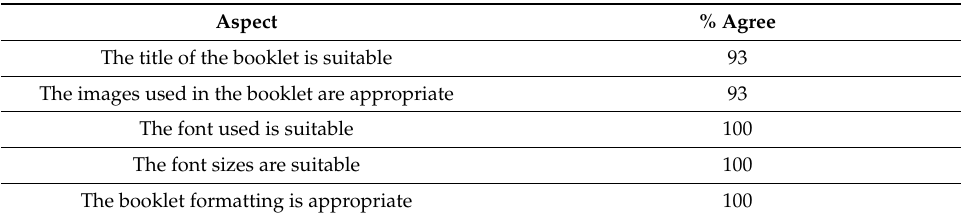
Table 3. Reviewers’ feedback results ( n =